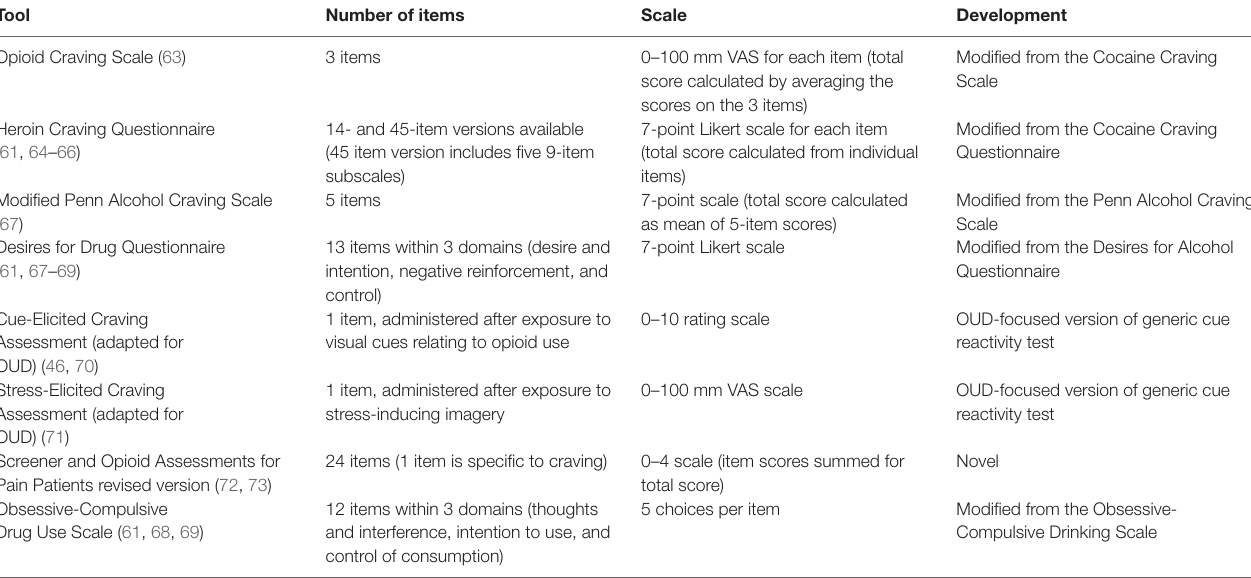
TABLE 1 | Self-reported craving tools for opioid use